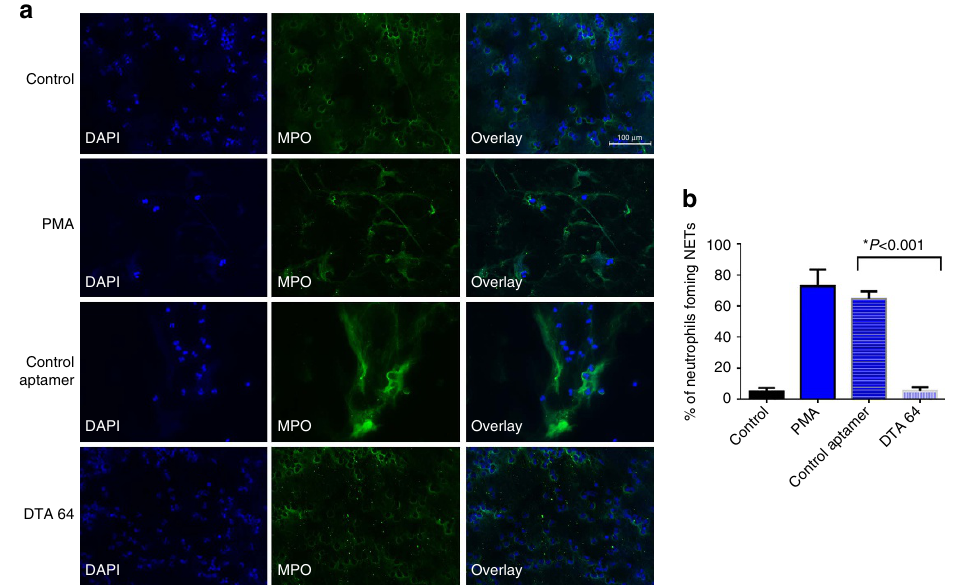
Figure 8 | DEK aptamers block NET formation by activated human neutrophils after 4h of stimulation with PMA. ( a ) Peripheral blood human neutrophils were obtained from healthy individuals and plated on glass coverslips. Aptamers to DEK were added at 50ng to the neutrophil culture prior to PMA stimulation (10ngml (cid:2) 1 ). Neutrophils were incubated for 4h at 37 (cid:2) C, then fixed and stained for NETs with anti-MPO antibodies (green) and DAPI for DNA (blue) ( (cid:3) 20 magnification, scale bar 100 m m). ( b ) Percentage of neutrophils forming NETs per field following treatment with control library aptamer as compared to neutrophils treated with anti-DEK aptamer (DTA 64) (* P o 0.001 as determined by two-tailed, unequal variance Student’s t -test ) (error bars, s.e.m.). Results shown are based on three different experiments from three different healthy donors and a total of 13 different fields counted by two different